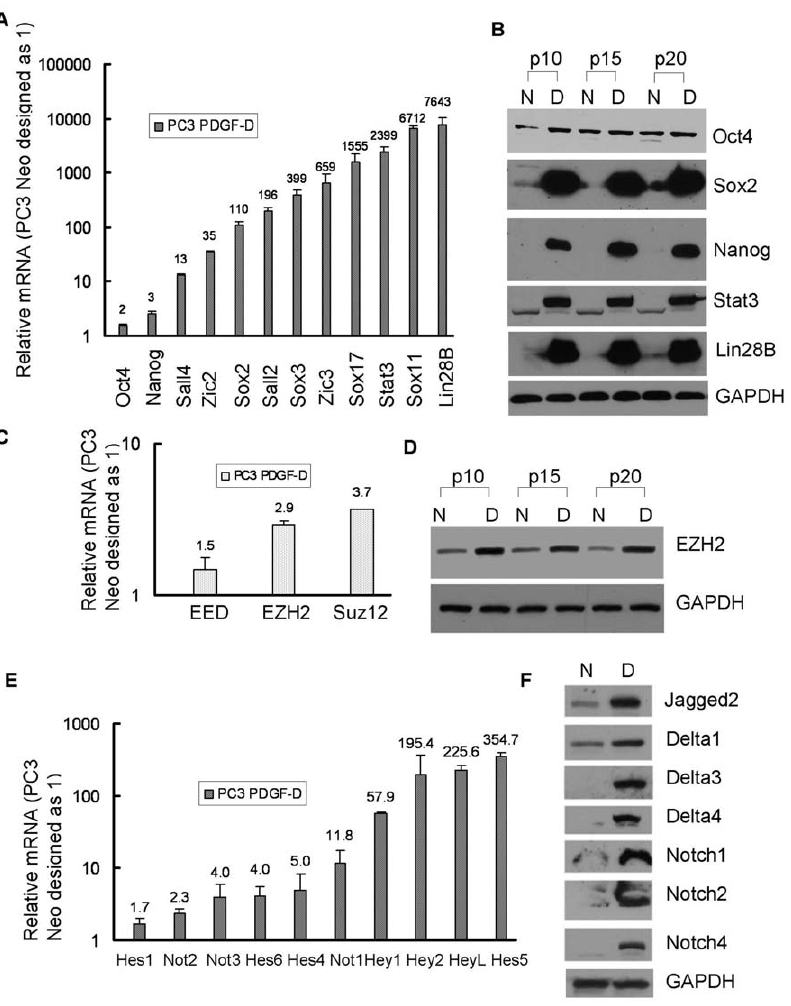
Figure 3. Gene expression profiling of stem cell markers in PC3 PDGF-D cells with EMT signatures. (A) The expression of genes at the mRNA levels for Oct4, Nanog, Sox family genes and Lin28B in PC3 Neo and PC3 PDGF-D cells were determined by using real time RT-PCR. (B) The results from Western blot showed that the expressions of Oct4 Sox2, Nanog, Stat3 and Lin28B were significantly increased in PC3 PDGF-D cells. (C) Real time RT-PCR was used to quantify the mRNA expression of EED, EZH2 and Suz12a. Relative mRNA levels were normalized to GAPDH. (D) The results from Western blot showed that the expression of EZH2 was significantly increased in PC3 PDGF-D cells. (E) The mRNA levels of Notch signaling factors in PC3 Neo and PC3 PDGF-D cells were determined by using real time RT-PCR. (F) The results from Western blot showed that the expressions of Notch and Notch ligands were significantly increased in PC3 PDGF-D cells. GAPDH was used for protein loading control. (N: PC3 Neo cells, D: PC3 PDGF-D cells,p10: passage 10).